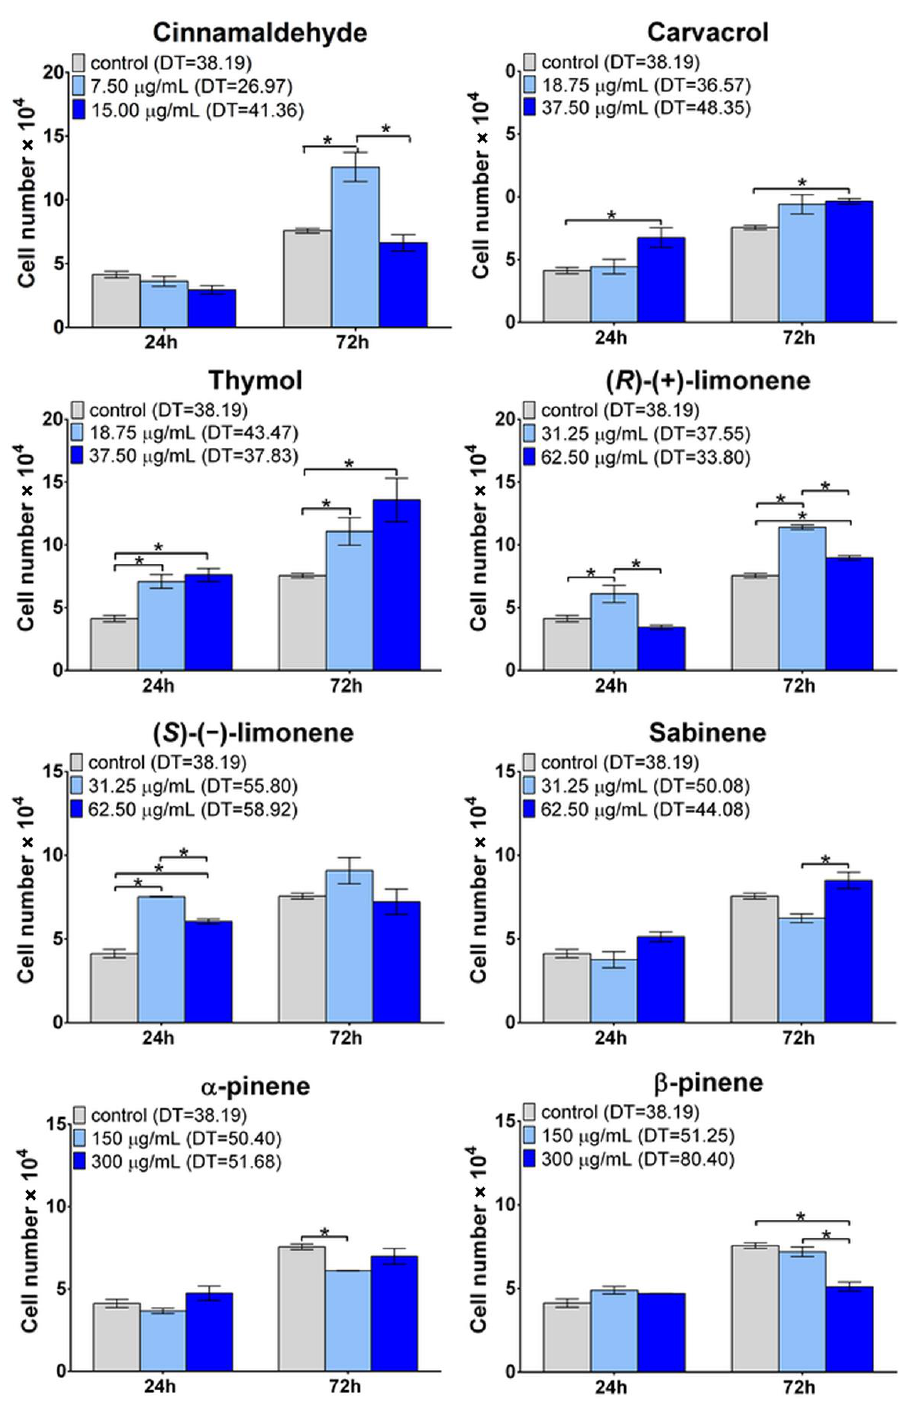
Figure 1. Influence of EO-derived compounds on mouse primary calvarial preosteoblast (MC3T3-E1 Subclone 4) proliferation in vitro. The total cell number was calculated using the Lactate Dehydrogenase Activity (LDH) Assay Kit (DT, doubling time in hours; * statistically significant results between indicated groups, n = 3, p < 0.05, one-way ANOVA followed by Tukey’s test).